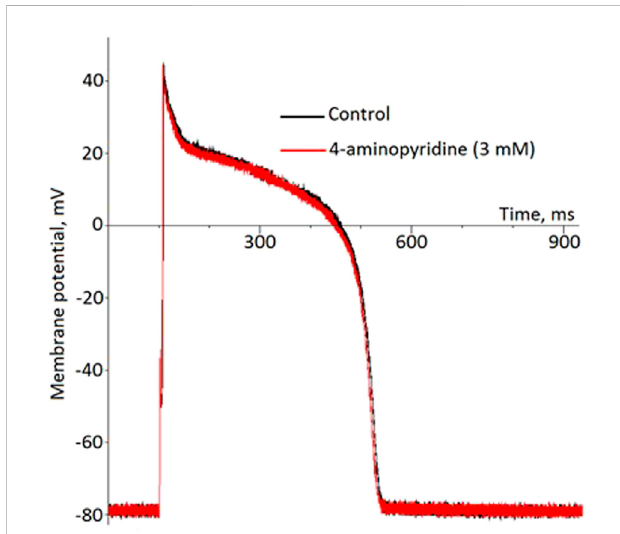
FIGURE 6 No effect of 4-aminopiridine on the ventricular action potential (representative recordings in the current-clamp whole-cell mode).